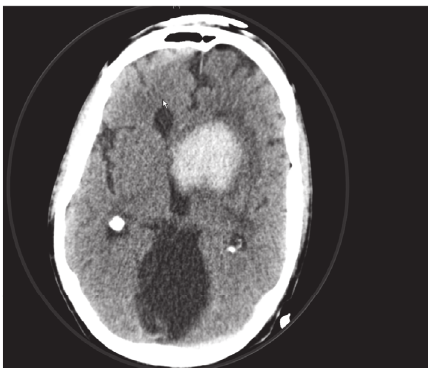
Figure 1: Angio-Head-CT shows a frontobasal left sided intrac- erebral bleeding with irruption into the ventricles and an enlarged ventricle system.